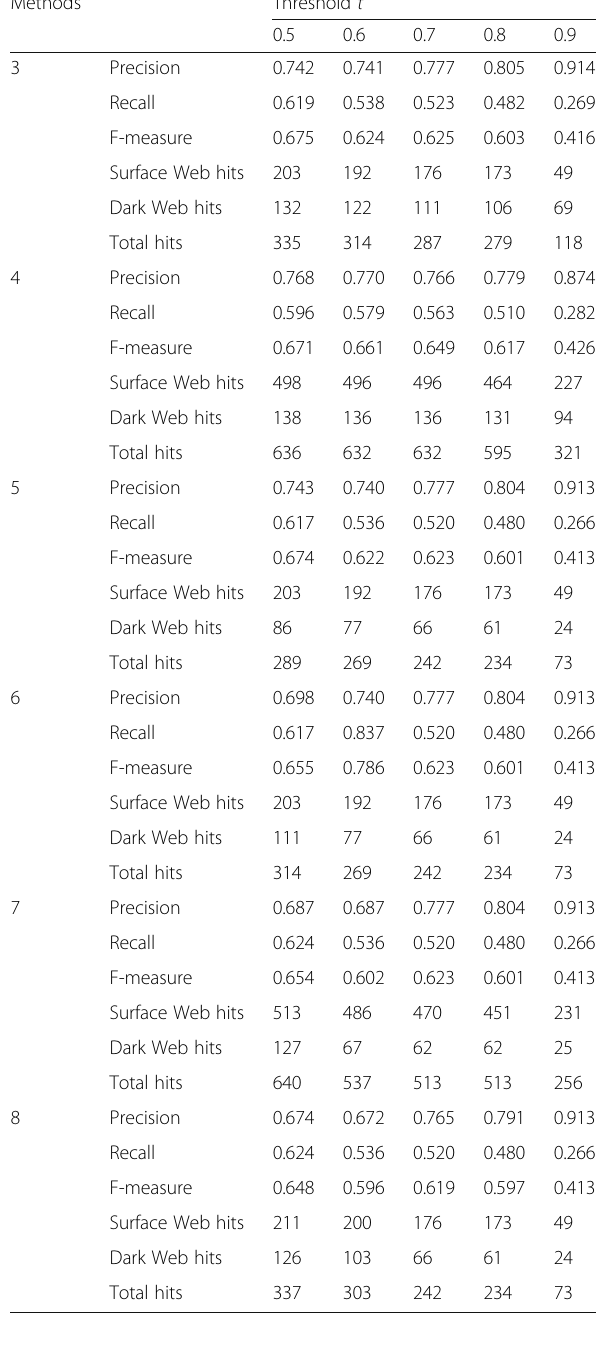
Table 4 Focused crawler effectiveness and efficiency when the second group of hyperlink selection methods are employed Methods